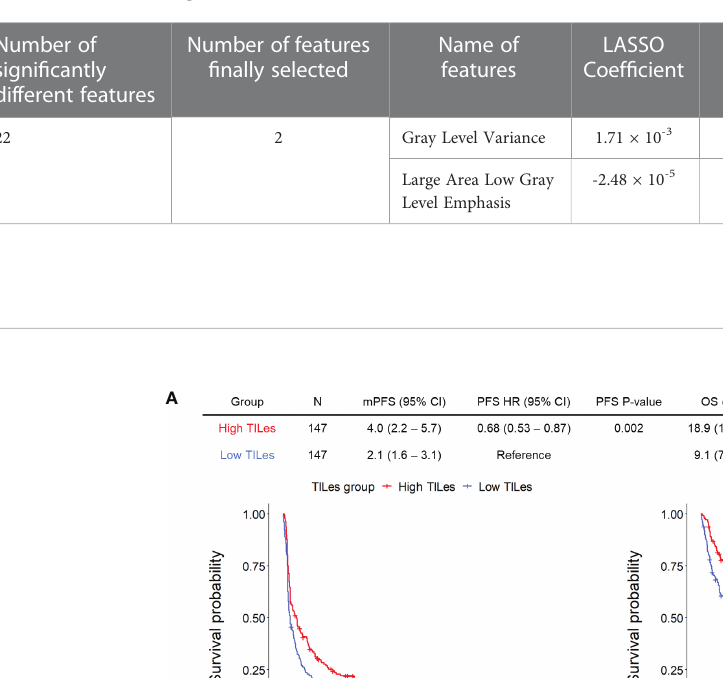
TABLE 2 The selected signi fi cant features associated with TILes.